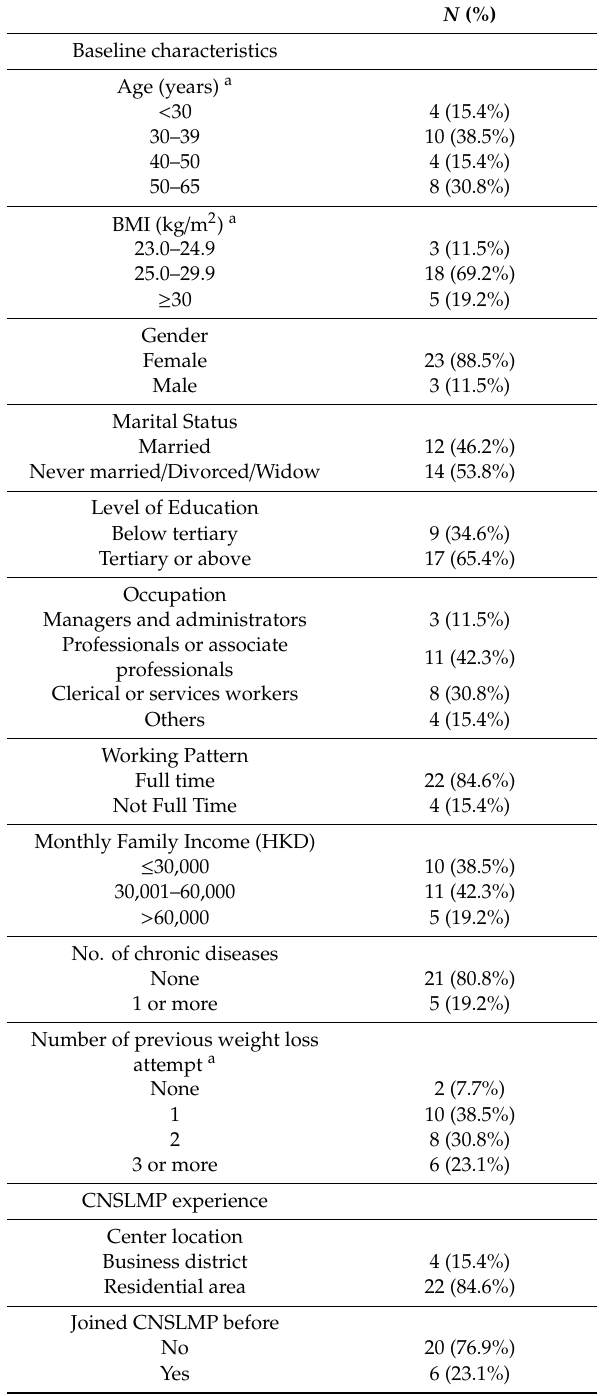
Table 5. Baseline demographic characteristics and program experience of interview participants (n =